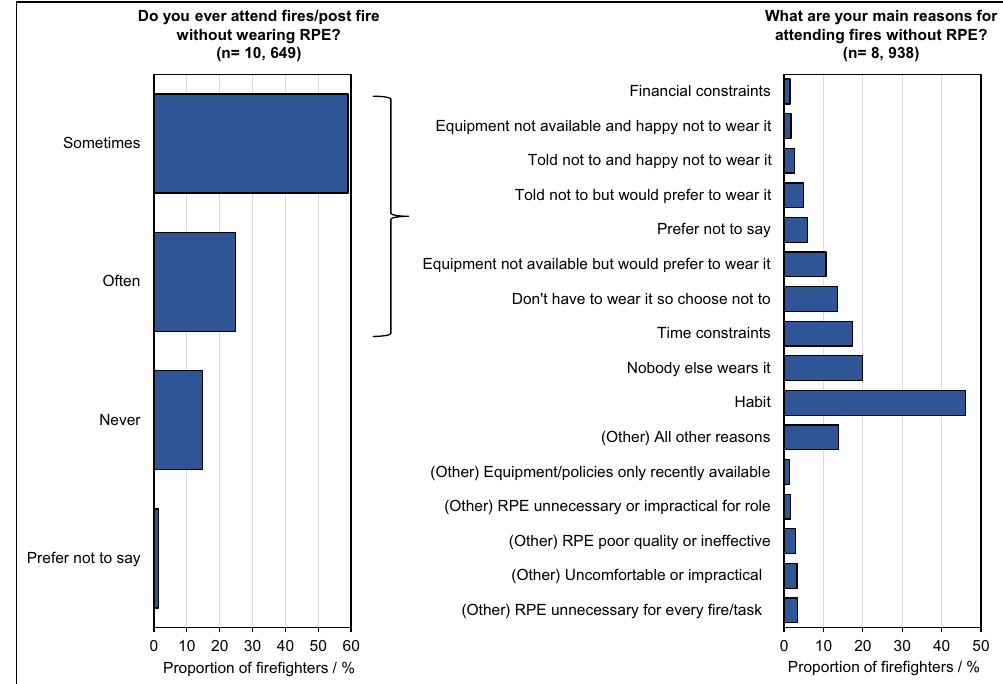
Figure 2. Attending fires without respiratory protective equipment. Proportion of total surveyed firefighters who attend fires without respiratory protective equipment (RPE), and their reasons for doing so. Note that firefighters were able to indicate more than one reason.